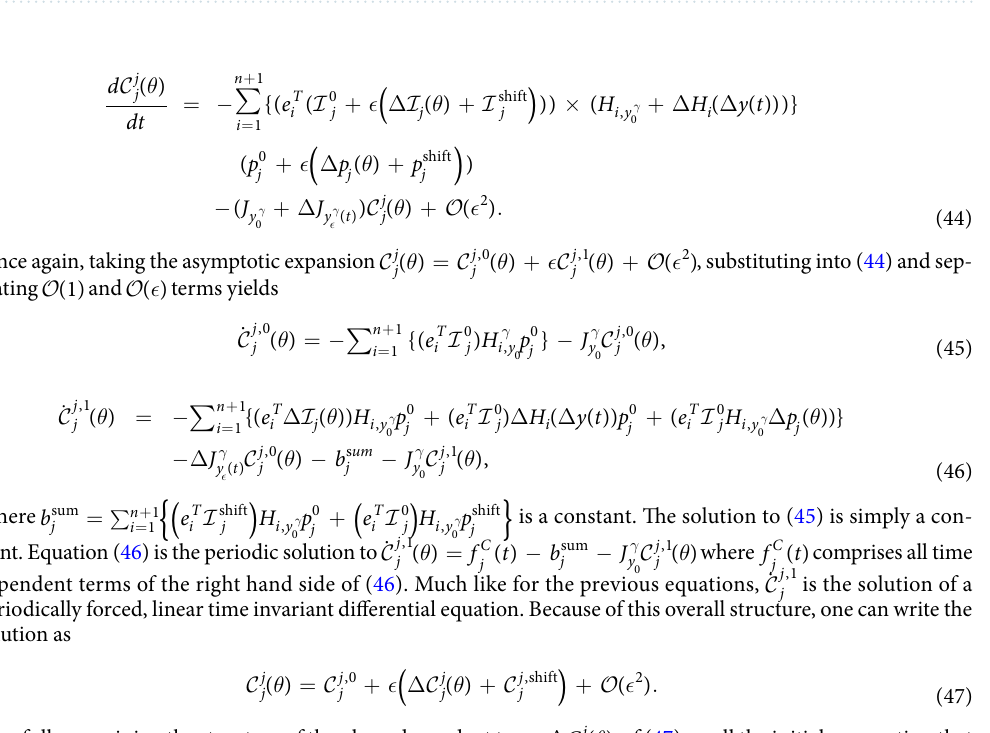
is is the periodic solution to the y t y y t ( ) ( )  0 j Δ γ J t ( ) is a linear y 